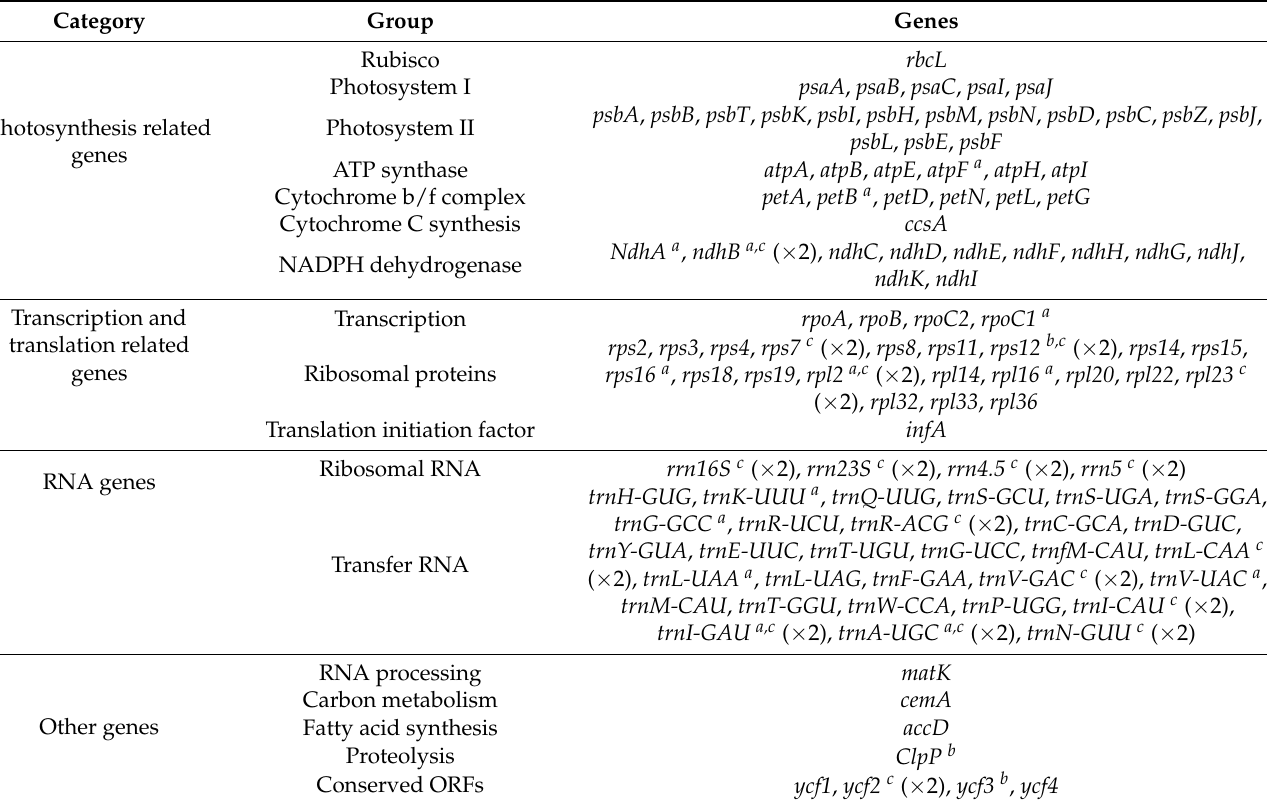
Table 1. Gene annotation of the S. saginoides and S. sessiliflora chloroplast